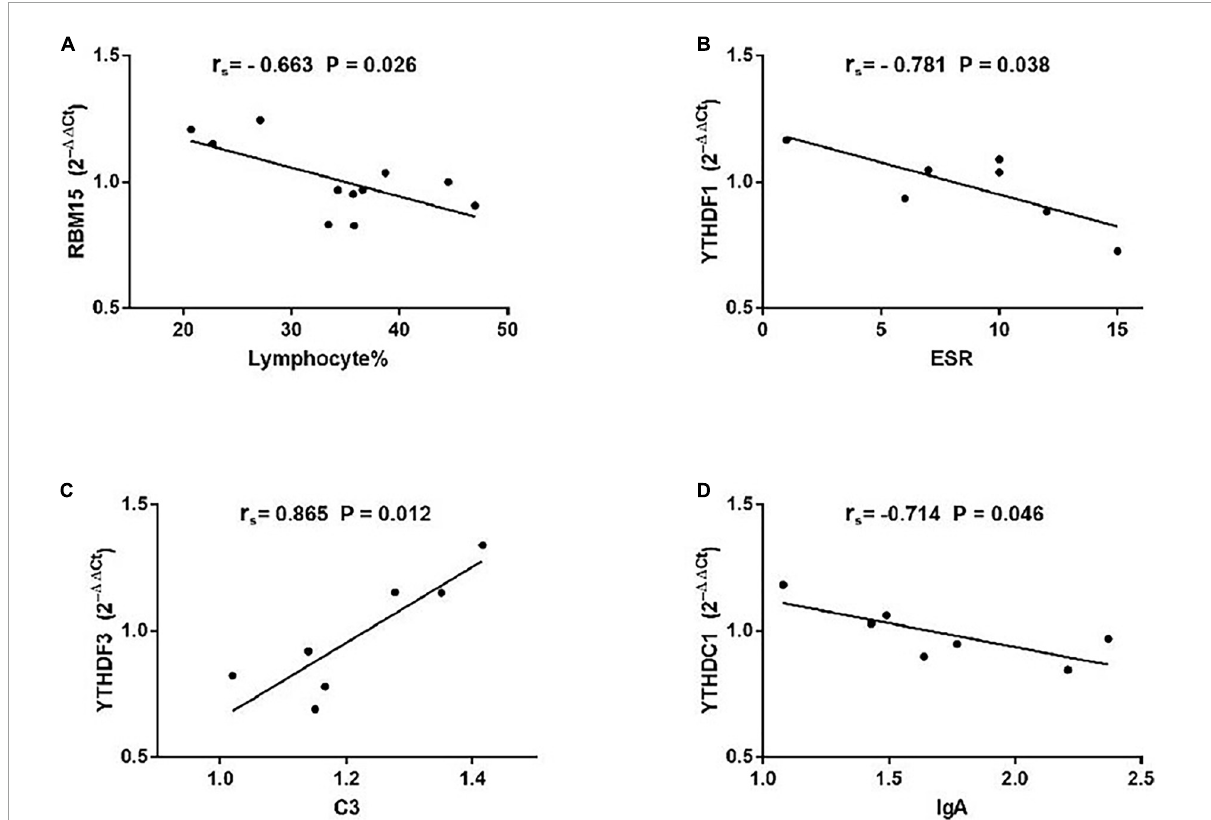
FIGURE5 Correlations between the expression of N6-methyladenosine-related genes and clinical data in patients with non-SS sicca. (A) The messenger RNA (mRNA) level of RBM15 was negatively correlated with lymphocyte%. (B) The mRNA level of YTHDF1 had a negative association with erythrocyte sedimentation rate (ESR). (C) The mRNA level of YTHDF3 had a positive association with complement 3 (C3). (D) The expression of YTHDC1 was negatively correlated with immunoglobulin A (IgA). ESR, erythrocyte sedimentation rate; C3, complement 3.